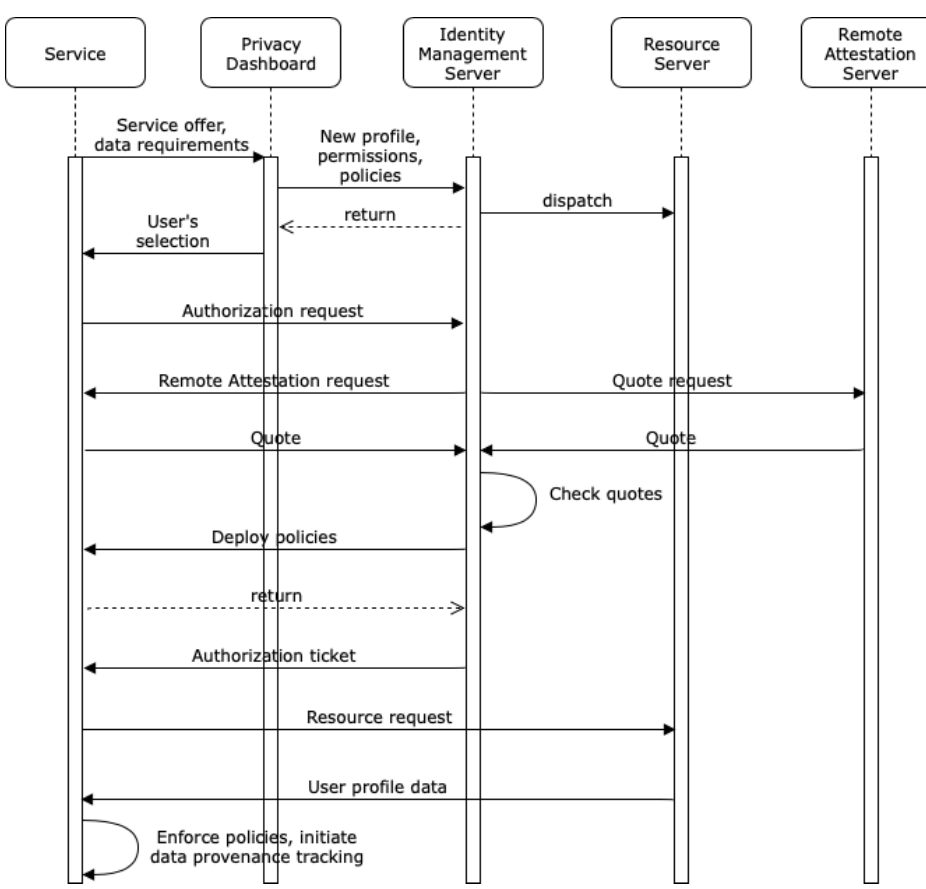
Figure 3. Interaction sequence of the described security mechanisms before using a